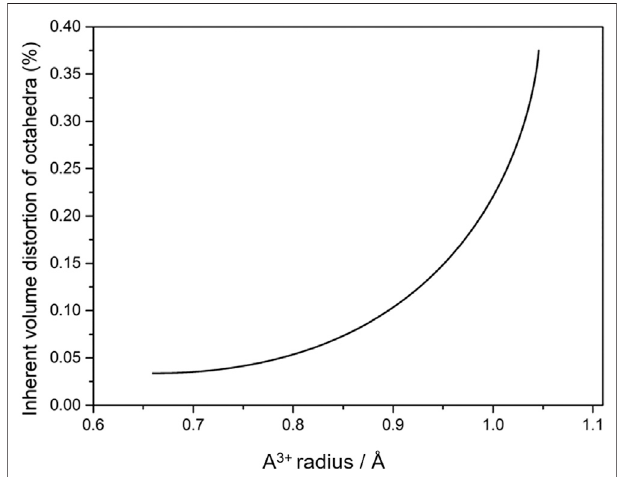
FIGURE 9 | Schematic view of the relationship between linear CTE and ionic force between A 3+ and O 2- in the A 2 M 3 O 12 family (styled from data in Romao et al.,